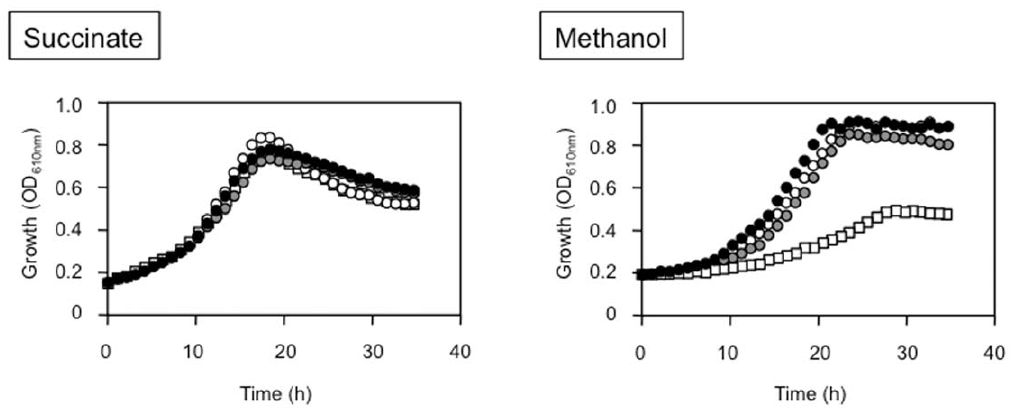
Figure 1. Growth of the wild-type strain AM1 on methanol or succinate media supplemented with Ca 2 + or/and La 3 + . The growth of strain AM1 on methanol or succinate media supplemented with Ca 2 + (black circle), with La 3 + (gray circle), with Ca 2 + + La 3 + (white circle) and without Ca 2 + and La 3 + (white square). The concentration of Ca 2 + and La 3 + in the medium are 30 m M each. Points on the graphs depict average data from three biological replicates.